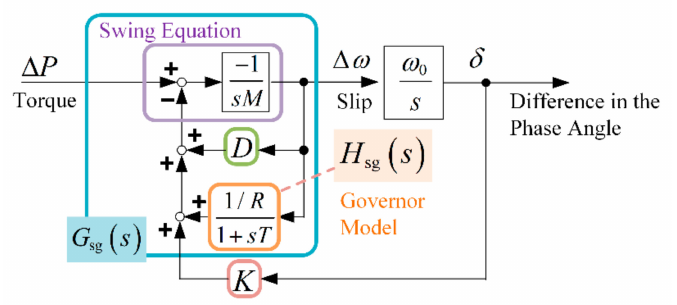
Figure 1. Torque equation of a synchronous